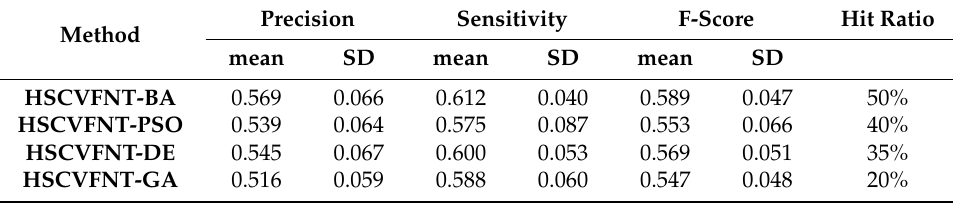
Table 6. Comparison of four methods for IRMA network inference with off